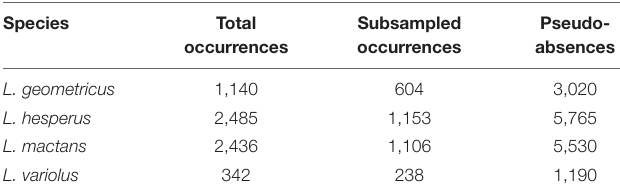
TABLE 1 | Counts for total occurrence points collected, systematically subsampled points, and pseudo-absences retained for model evaluation for each